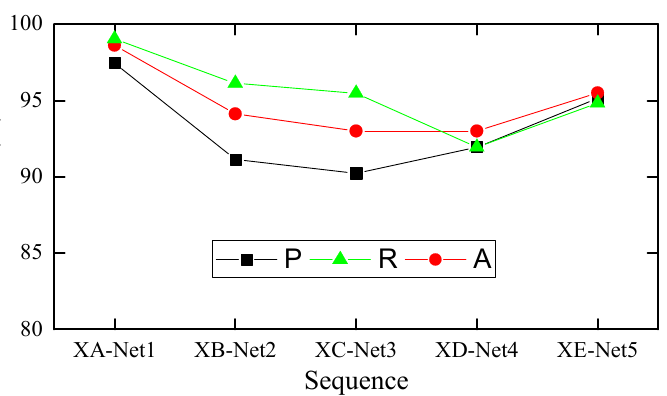
Figure 7. The precise (P), recall (R) and accuracy (A) of the detection results.